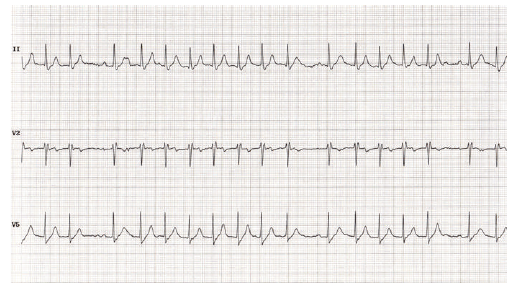
Figure 2: ECG during exercise test showing intermittent high grade AV block.